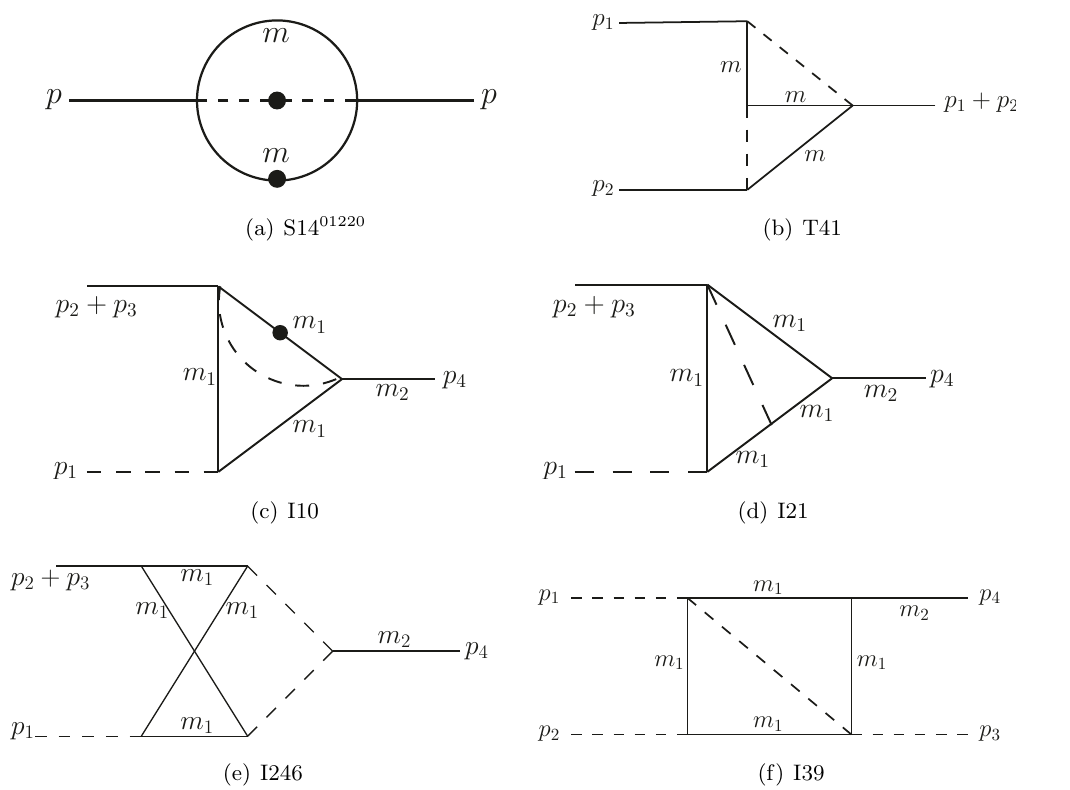
Figure 1 . The two-loop (cid:12)nite sunrise S14 01220 and triangle T41, I10, I21 graphs for which analytical results are available [72, 73]. No fully analytical expressions exist for the non-planar I246, (e), and the box-type integral I39, (f). Dashed lines indicate massless, solid internal lines massive, and dots squared propagators. Solid external lines denote, where indicated, massive and else o(cid:11)-shell particles.